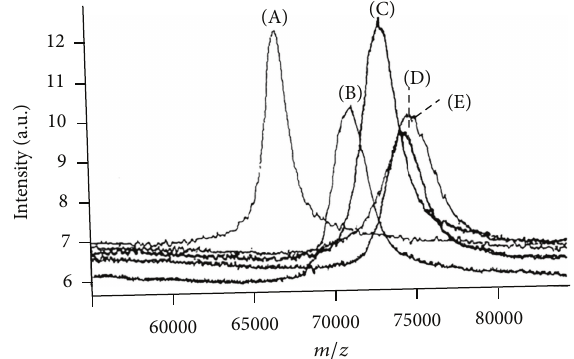
Figure 1: MALDI spectra of BSA incubated with 2M glucose at concentration (pH 7.5; 37 ∘ C) recorded at different incubation times: (A) incubation time, 0 days, molecular mass 66429 Da; (B) incubation time, 7 days, molecular mass 71103Da; (C) incubation time, 14 days, molecular mass 73099 Da; (D) incubation time, 21 days, molecular mass 74279 Da; (E) incubation time, 28 days, molecular mass 74682 Da. From [11], by kind permission of John Wiley and Sons through RightsLink, License no.